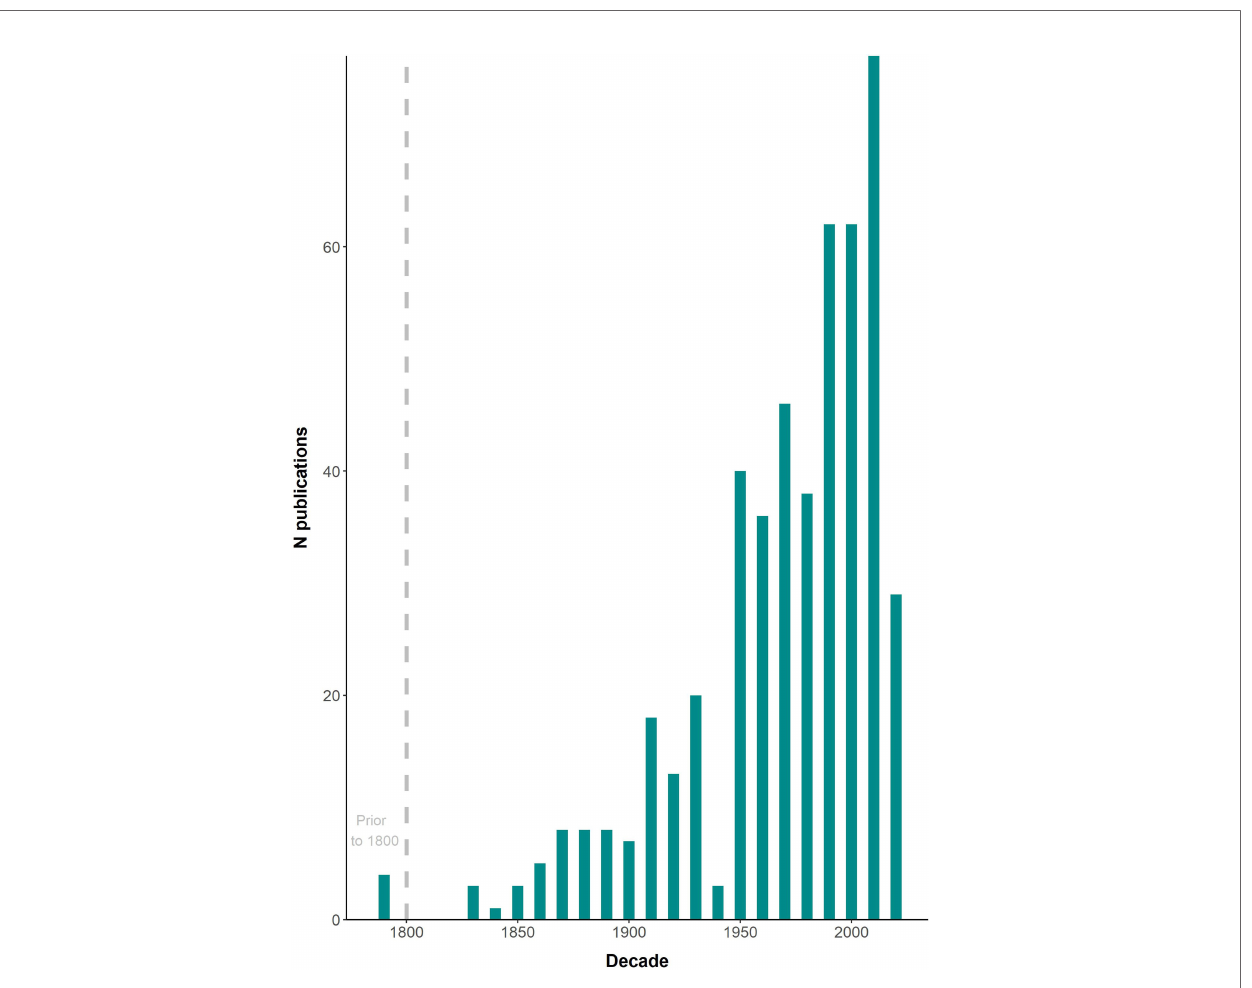
FIGURE 2 | Number (N) of publications including data on cetacean epibiotic fauna at a decadal scale from 1655 to